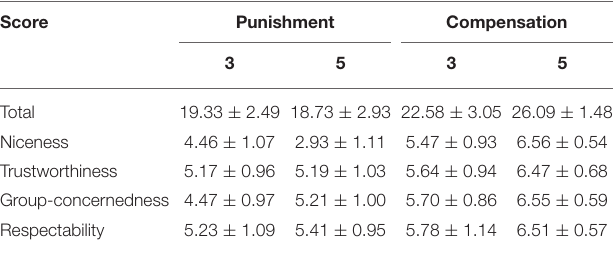
TABLE 3 | The reputational scores of different transfer amounts for punishment and compensation ( M ± SD ).